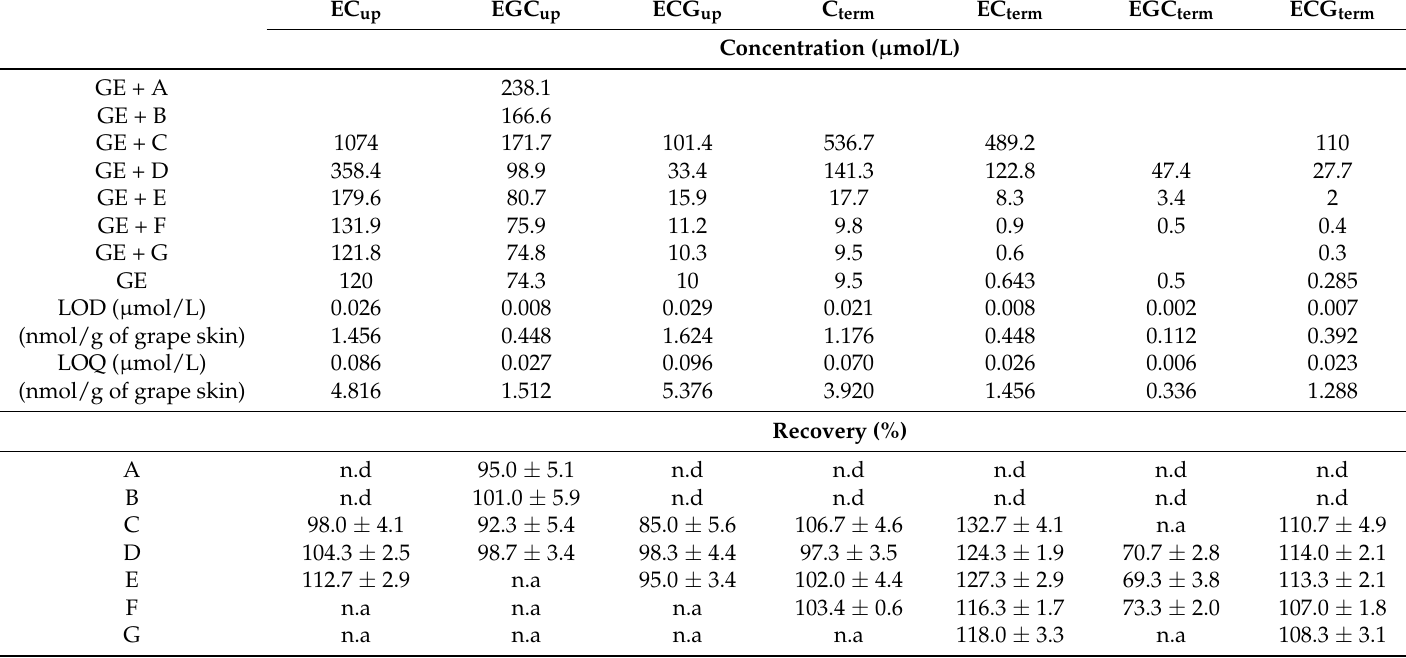
Table 3. Concentration levels ( µ mol/L) for each compound in the solutions used for method validation and method validation parameters: limits of detection (LOD) and quantification (LOQ), recovery and precisions intra and inter-day, suppression/enhancement effect and stability at different concentration levels (GE: grape skin extract used for method validation (Table 2) A–G: standard solutions, Supplementary Materials, Table